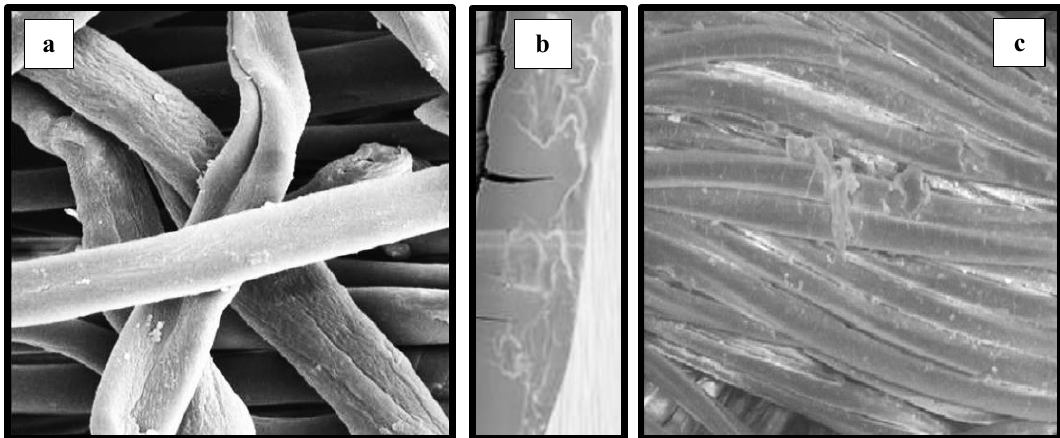
Fig. 6. SEM images of poly (ethylene terephthalate) knitted materials after various irradiation: a) Poly (ethylene terephthalate)/viscose fabric (with a ratio of 65% polyester and 35% viscose) after microwave irradiation[11], b) Poly(ethylene terephthalate) non-textured fabric after gamma irradiation[12], c) Poly(ethylene terephthalate) plain weave fabric after min UVC